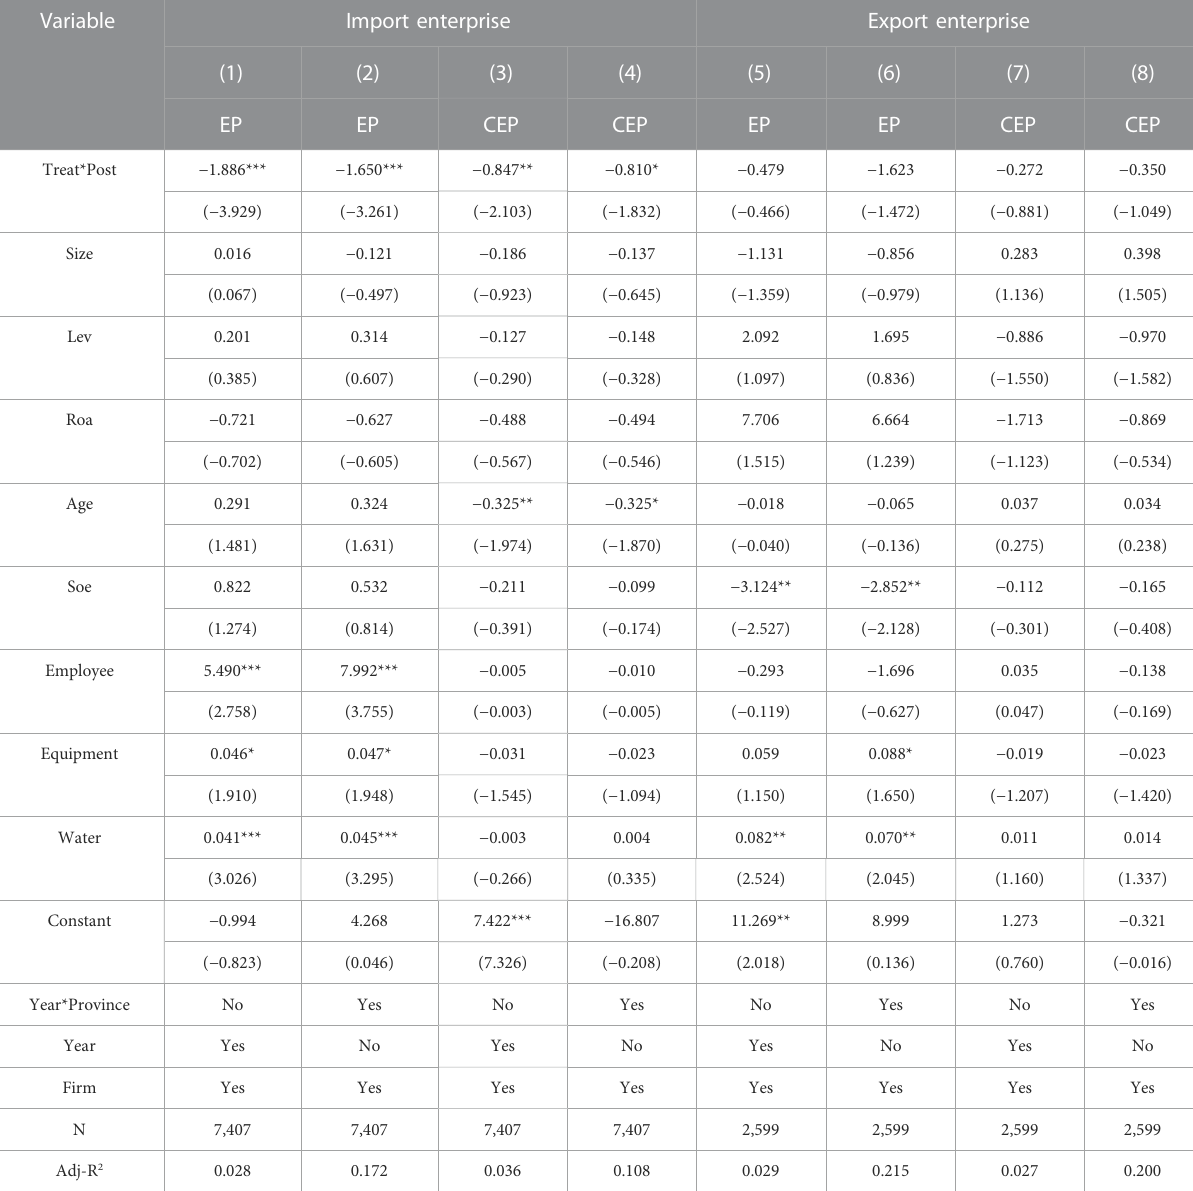
TABLE 5 NSMF program, import/export enterprises, and corporate environmental